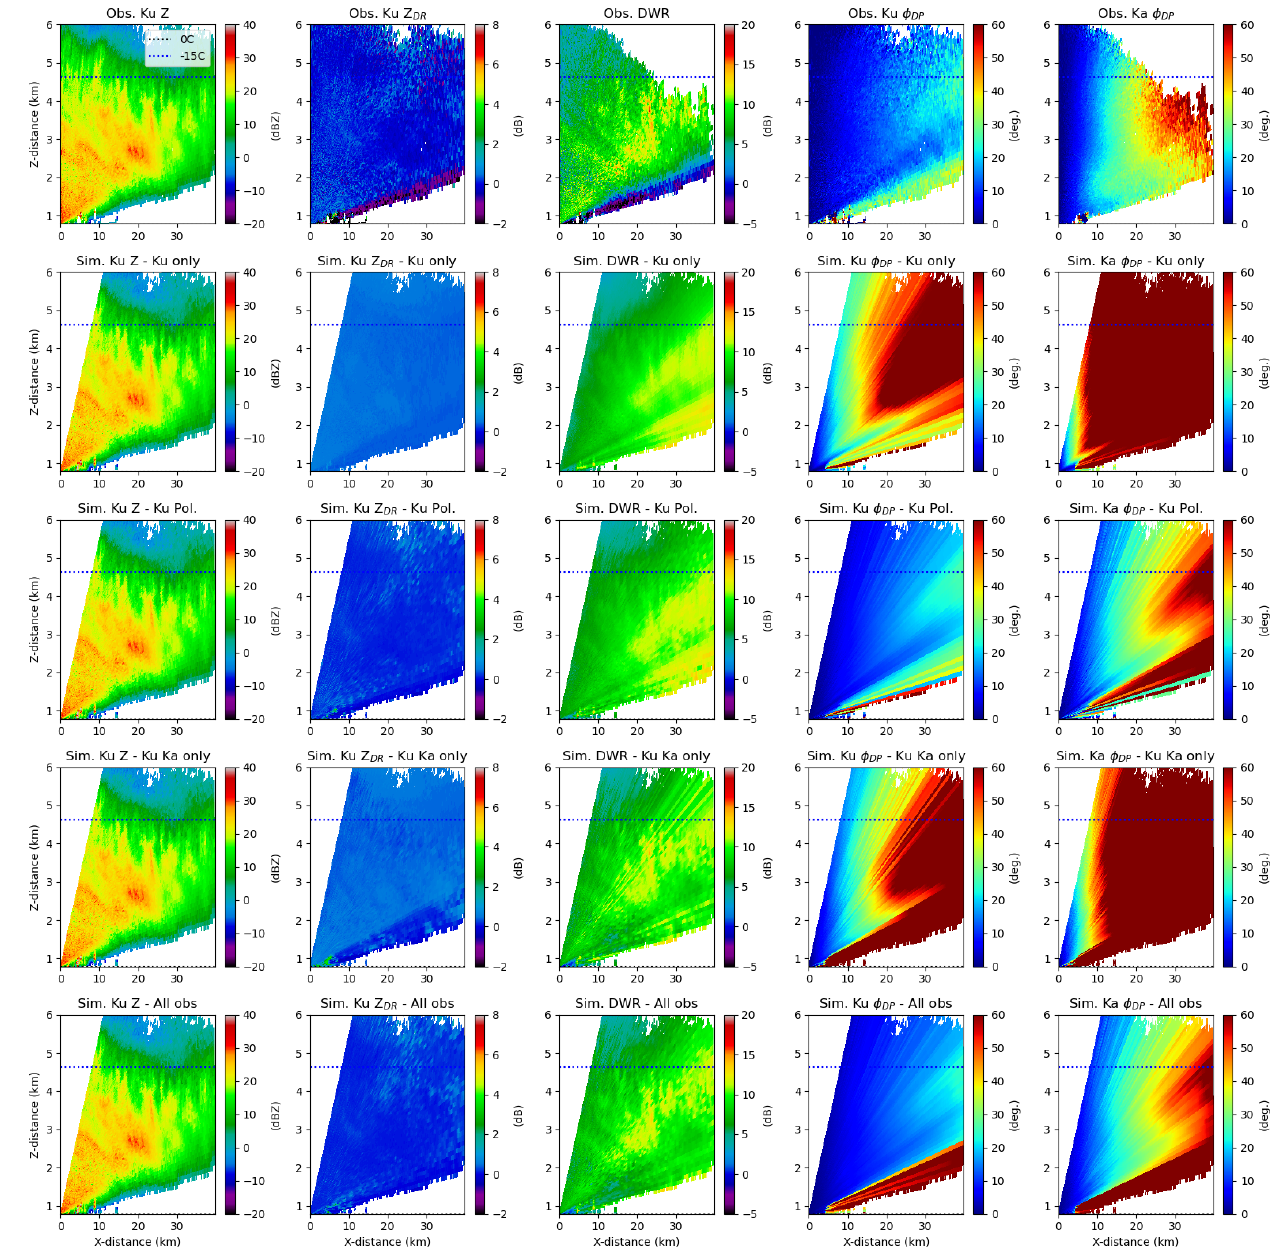
Figure 7. Observed and simulated Z H (first column), Ku-band Z DR (second column), DWR (third column), Ku-band (cid:56) dp (fourth column), and Ka-band (cid:56) dp (fifth column). The observed radar variables are shown on the first row, the simulated radar variables from the Ku-band reflectivity retrieval are shown in the second row, the simulated radar variables from the Ku-band polarimetric retrieval are shown in the third row, the simulated radar variables from the Ku-band and Ka-band reflectivity retrieval are shown in the fourth row, and the simulated radar variables from the full-observation retrieval are shown in the fifth row. The observations are from an RHI taken at 13:00UTC on 28 February at an azimuth angle of 231 ◦